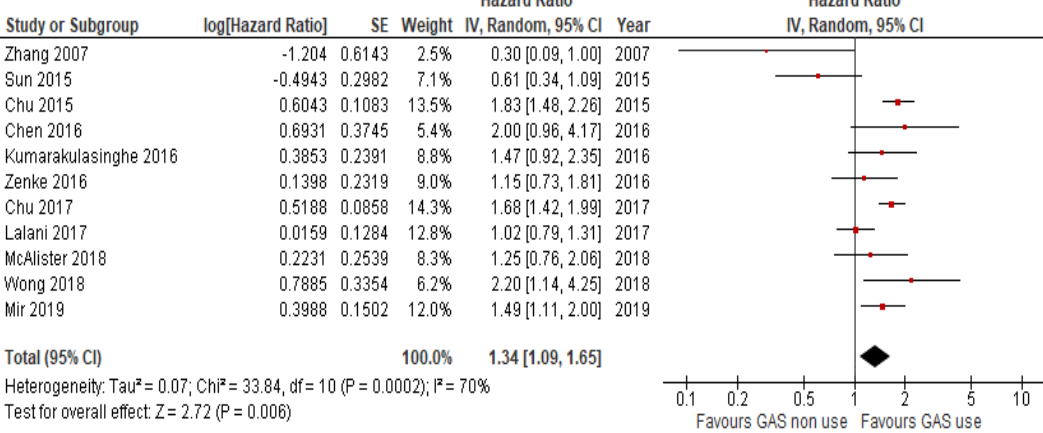
Figure 2. Forest plot for overall survival of the analyzed studies.